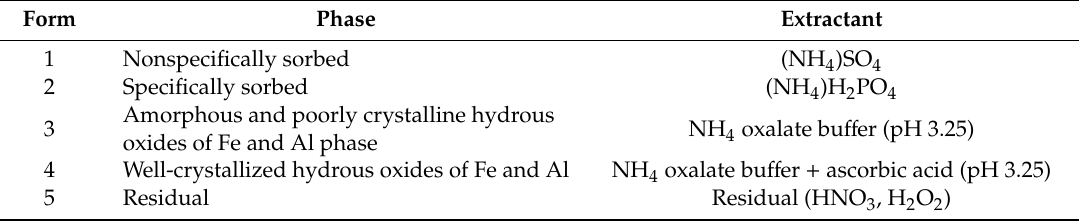
Table 1. Sequential extraction procedure for the fractionation of arsenic (adapted from [36]).